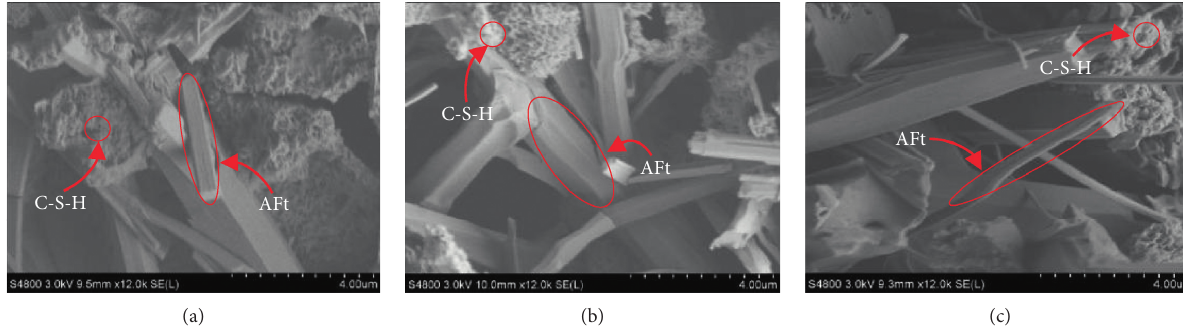
Figure 5: SEM image of LASC cured foam filling material when molded for one day. (a) FGS 1. (b) FGS 2. (c) FGS 3.